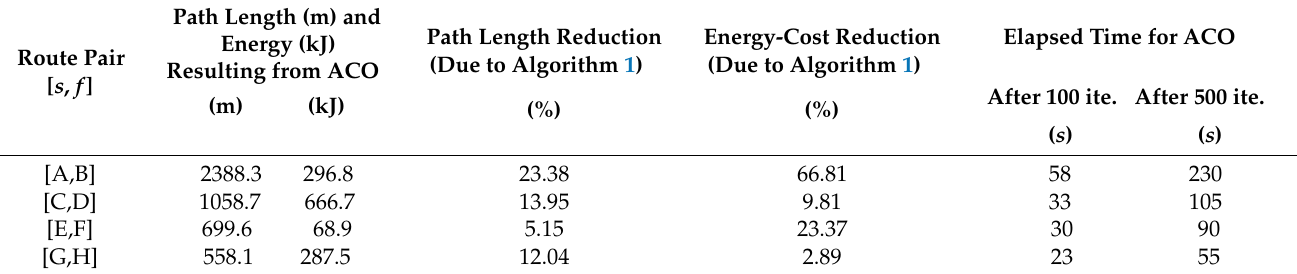
Table 2. Ant Colony Optimization (ACO) results and